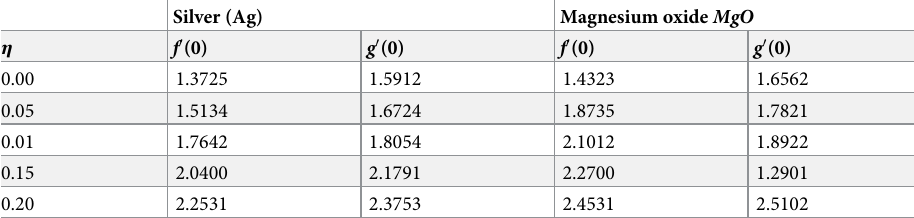
Table 3. The comparative analysis of silver and magnesium-oxide nanoparticles on velocity profile.